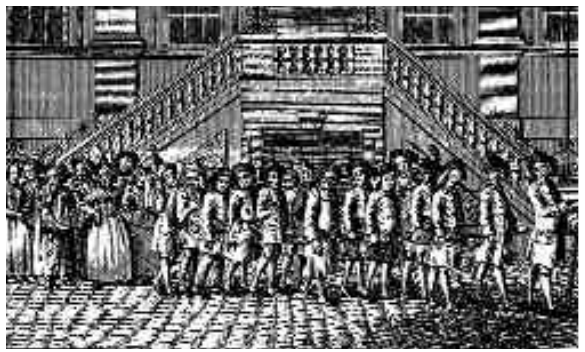
Fig. 4. Convicts in chains await transportation to prison colonies abroad